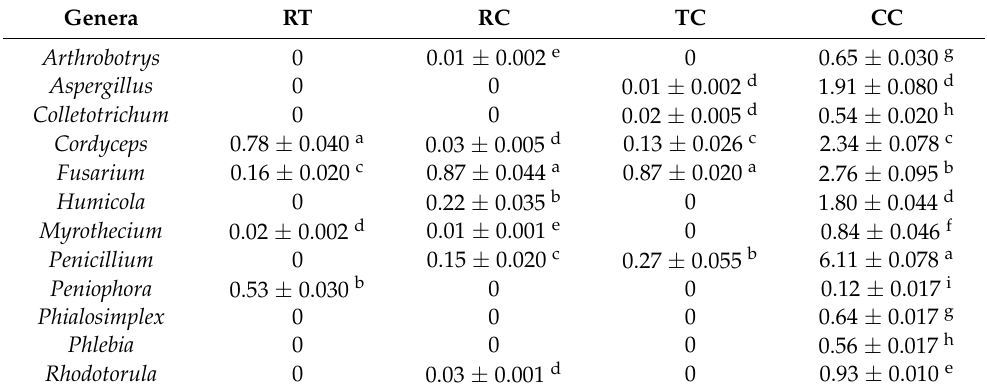
Table 4. Population abundance of the dominant fungi genera under four cropping patterns (%).